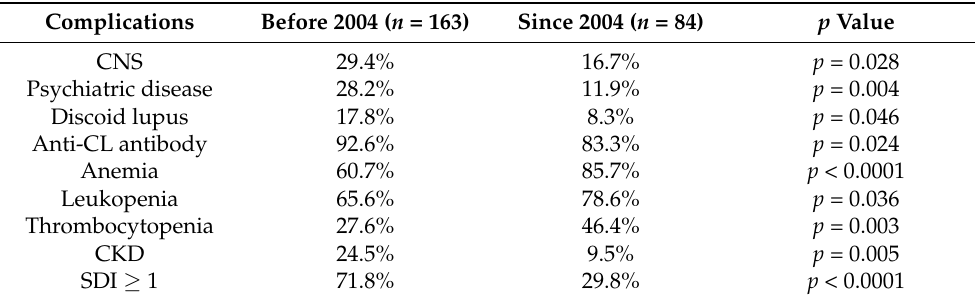
Table 5. Differences in the clinical symptoms and laboratory findings between patients of the APA positive non-APS group diagnosed with SLE before and since 2004.